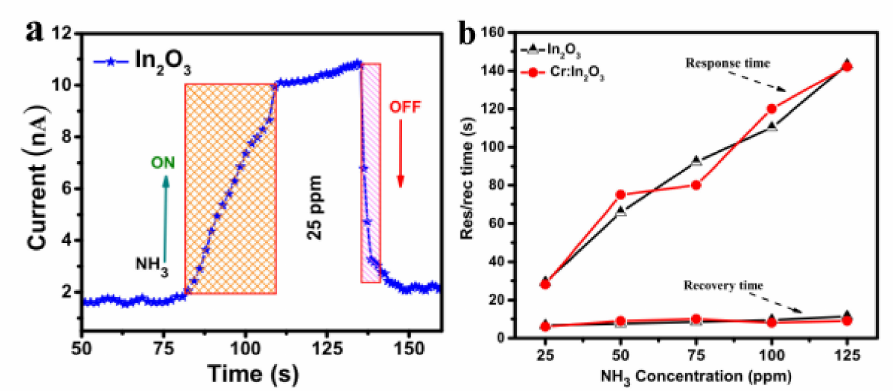
Figure 9. ( a ) Plot of response/recovery time at 25 ppm for pure In 2 O 3 , ( b ) variation of response and recovery times for pure and doped films with respect to different NH 3